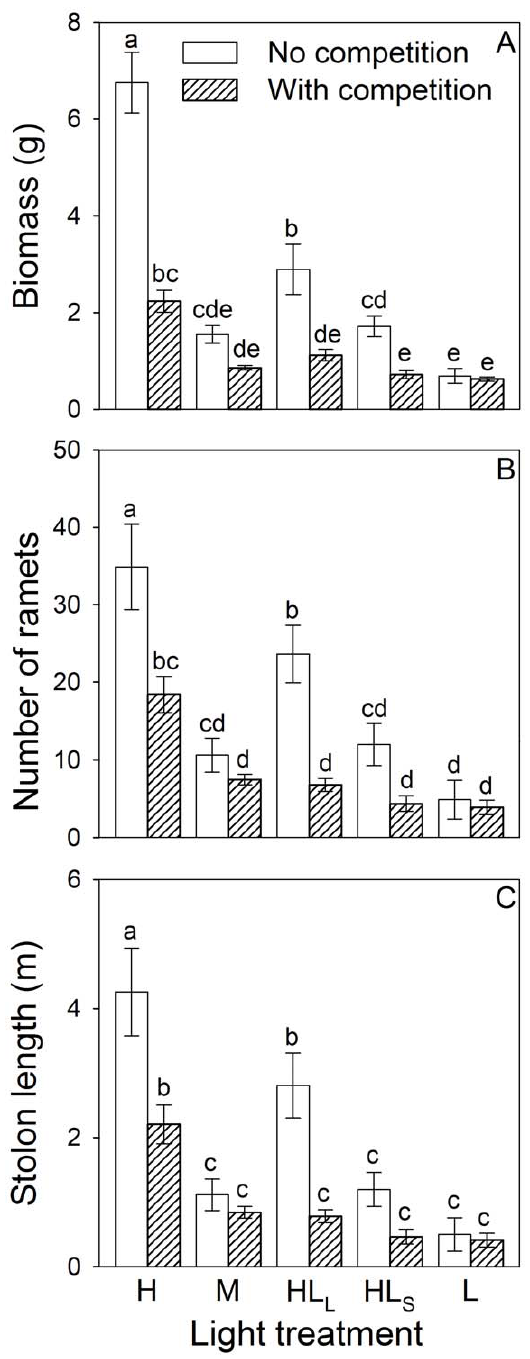
Figure 2. Effects of competition and light treatment on the whole clone of Duchesneaindica . Mean values ( + SE) of biomass (A), number of ramets (B) and total stolon length (C) are given. Bars sharing the same letters are not different at P =0.05. Treatment codes are in Figure 1.